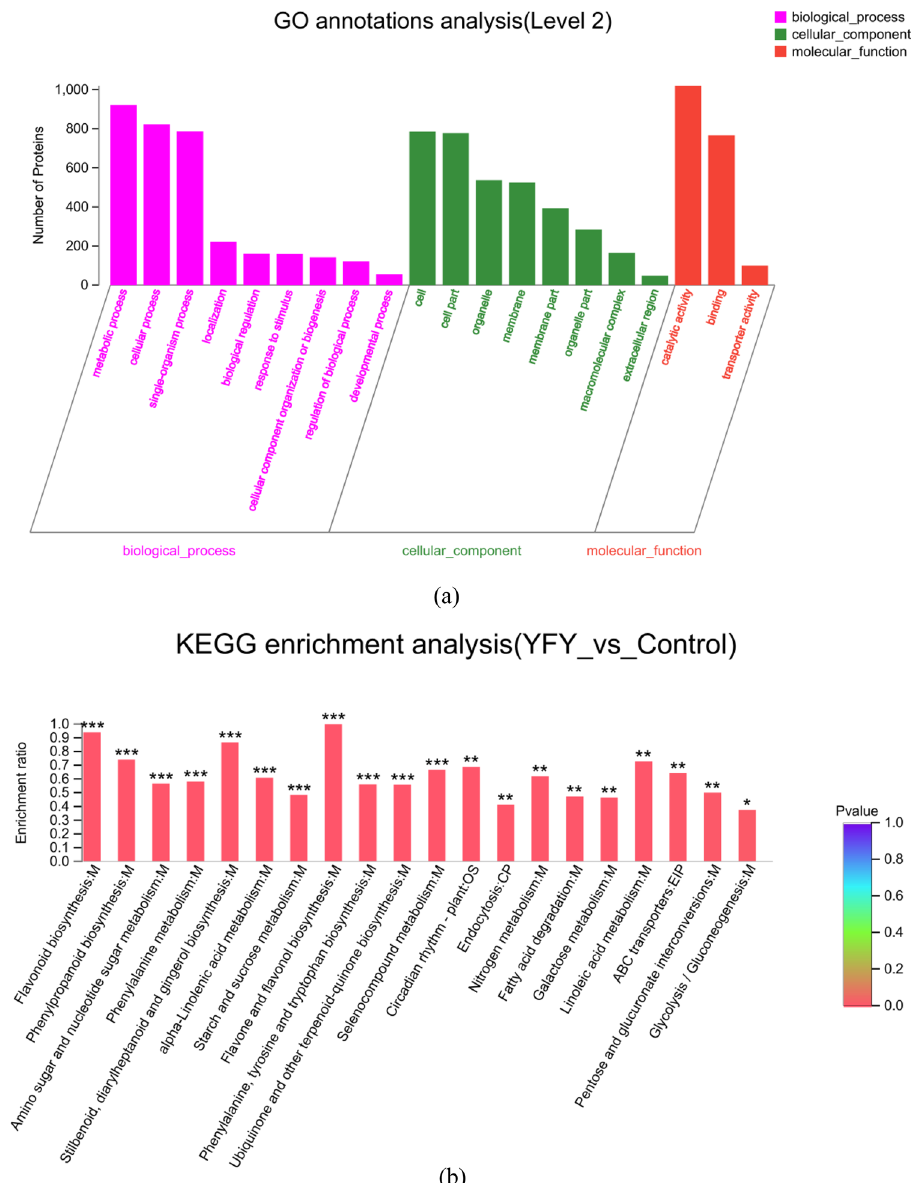
Figure 5. ( a ) GO terms enrichment of differentially expressed proteins. Each column represents a secondary classification of GO; a taller bar corresponds to more protein in the secondary classification. The abscissa represents the secondary GO classification term, and the ordinate represents the number of proteins annotated to each secondary classification. ( b ) KEGG enrichment analysis results. The abscissa represents the pathway name, and the ordinate represents the enrichment rate (i.e., ratio of the number of proteins enriched in the pathway to the number of proteins annotated in the pathway; a larger ratio corresponds to a greater degree of enrichment). The color gradient within the column indicates the significance of enrichment, with a darker color indicating greater enrichment in the KEGG term. ***Indicates P or FDR < 0.001; **indicates P or FDR < 0.01; and *indicates P or FDR <